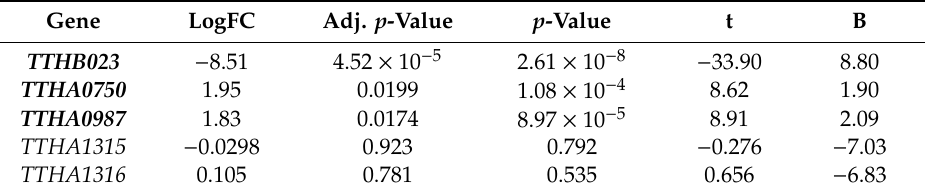
Table 4. GEO2R analysis of genes with identified TTHB023-binding sites in their